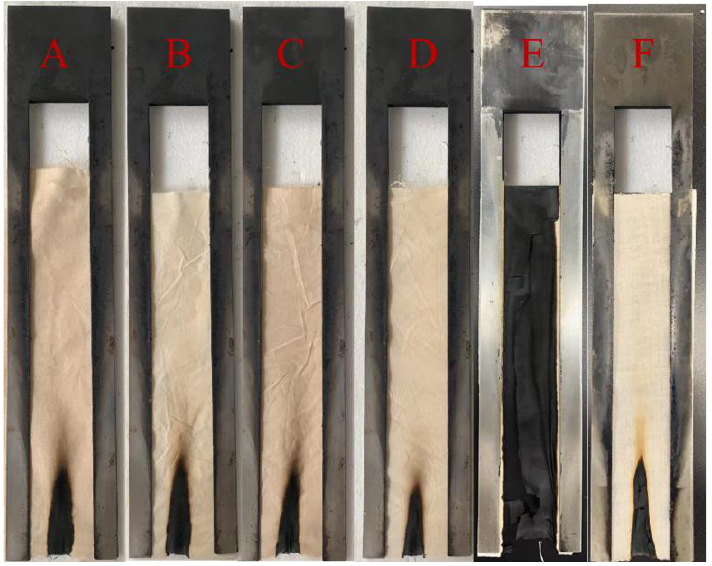
Figure 3. VFT photos of the samples: PAP-100 ( A ), PAPBTCA-100 ( B ), PAP-200 ( C ), PAPBTCA-200 ( D ), Table 1. Flame-retardant performance of the samples.